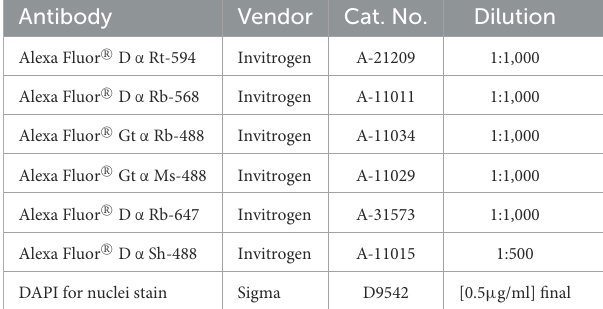
TABLE 3 Secondary